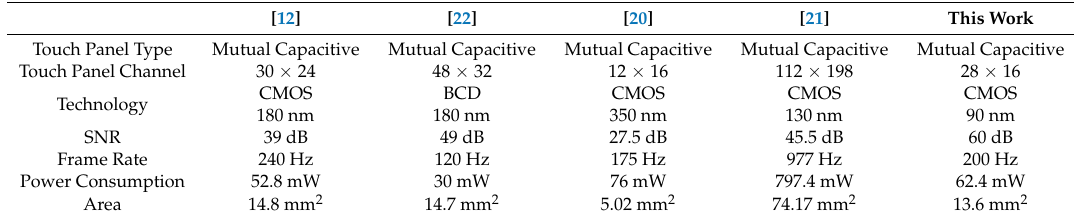
Table 1. Performance of the analog front end for the touch